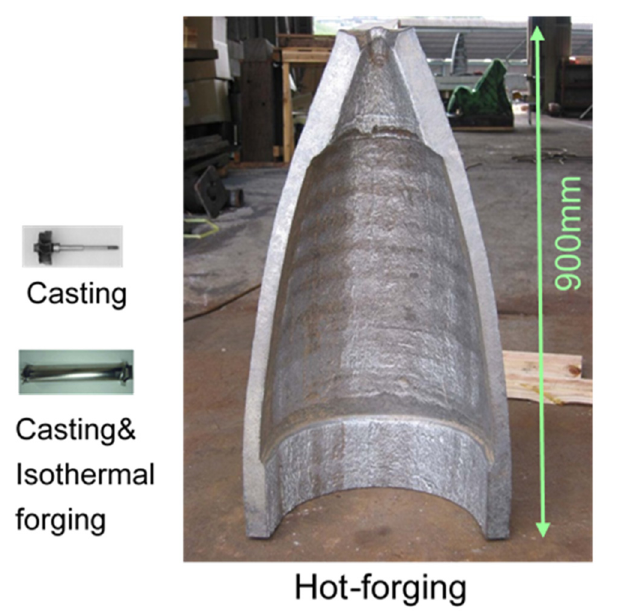
Figure 2. Comparing the actual size of products produced by various methods.